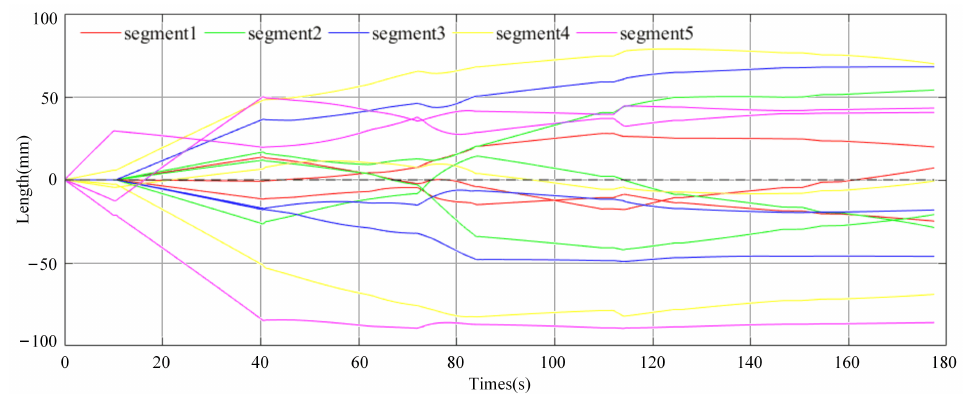
Figure 11. Simulation interfaces.